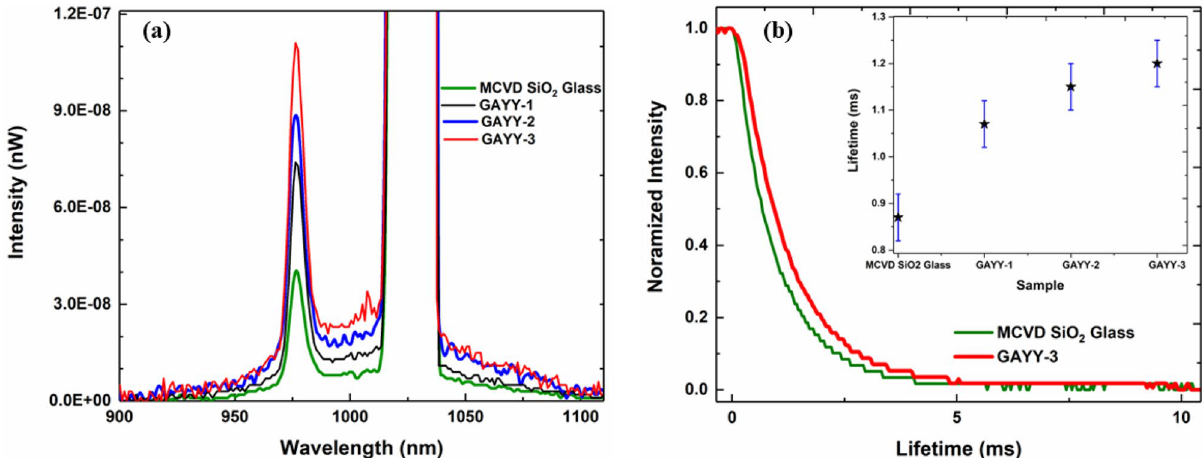
Figure 2. ( a ) The anti-Stokes emission in all the GAYY glasses as well as MCVD SiO 2 glass while exciting with 1029 nm laser with 5 W pump power, ( b ) The lifetime decay curves of MCVD SiO 2 glass and GAYY-3 at an excitation wavelength of 920 nm. The inset shows the lifetime values of all